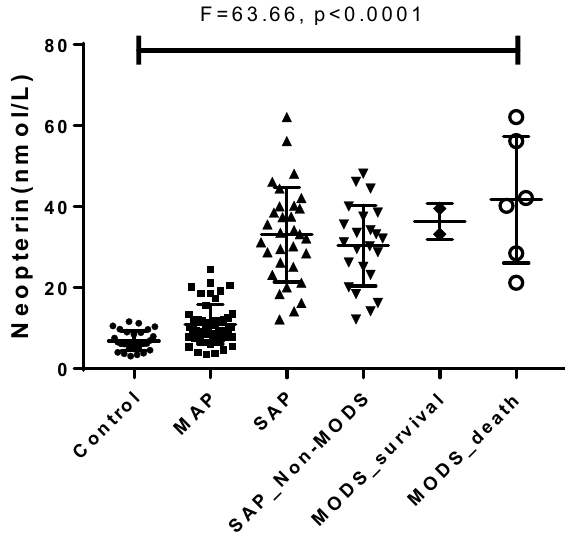
Figure 1: Scatter plot of serum neopterin for each group(Tested by ANOVA, F=63.33, p<0.0001 ).